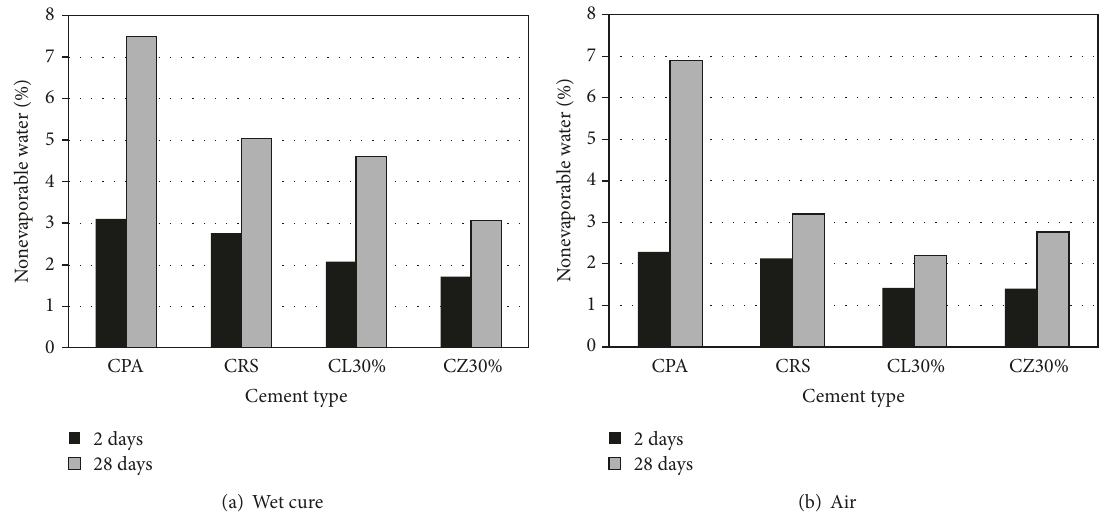
Figure 12: (a), (b) Nonevaporable water of cement pastes retained in the wet cure and air at 2 days.